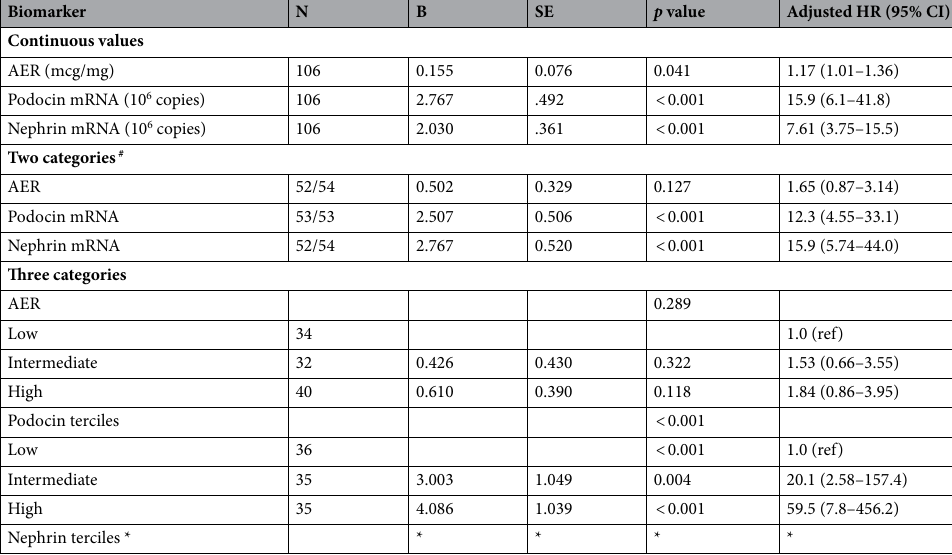
Table 2. Hazard Ratios for the development of cardiovascular disease derived for all three urinary biomarkers considered as continuous or categorical biomarkers. N = number of subjects; B (SE) = cox regression coefficient (standard error); HR (95% CI) = hazard ratio (95% confidence interval). Data adjusted for the following Visit 1 factors: gender, age, body mass index, smoking, hypertension (yes/no), statin use (yes/no), systolic and diastolic blood pressure, triglyceride, low and high density lipoprotein, and hemoglobin A1c levels. # Biomarker groups divided to sub-cohorts based on the median visit 1 value. *Not calculated since no subjects in the low nephrin tercile group had documented CVD during